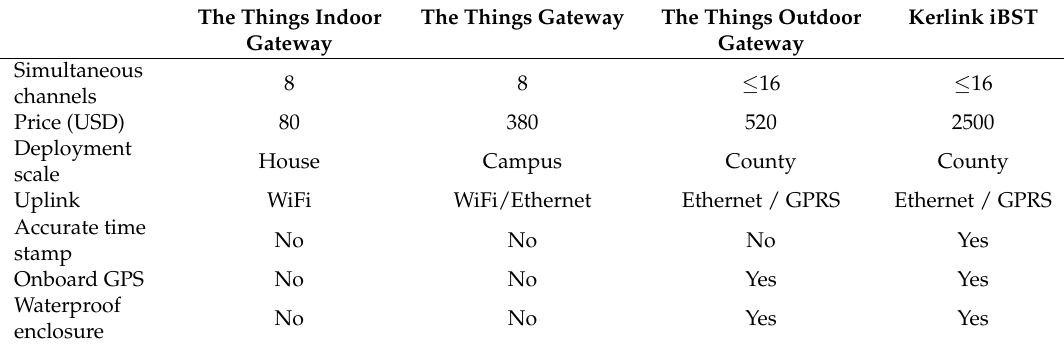
Table 4. Comparison of different commercial LoRaWAN gateway solutions. Prices are correct as of December 2019 and exclude external antenna, mounting hardware, and power